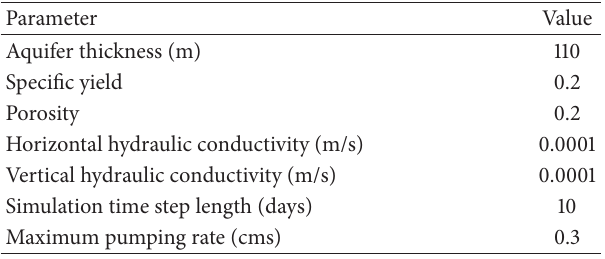
Table 2: Aquifer properties and simulation parameters.